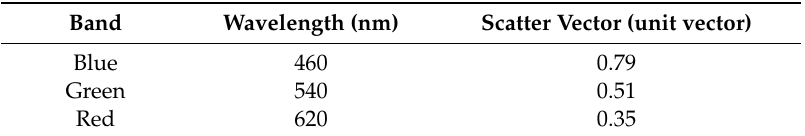
Table 2. Di ff use skylight scatter vector calculated from Angstrom-law exponent –2.6549 for Canon 450D